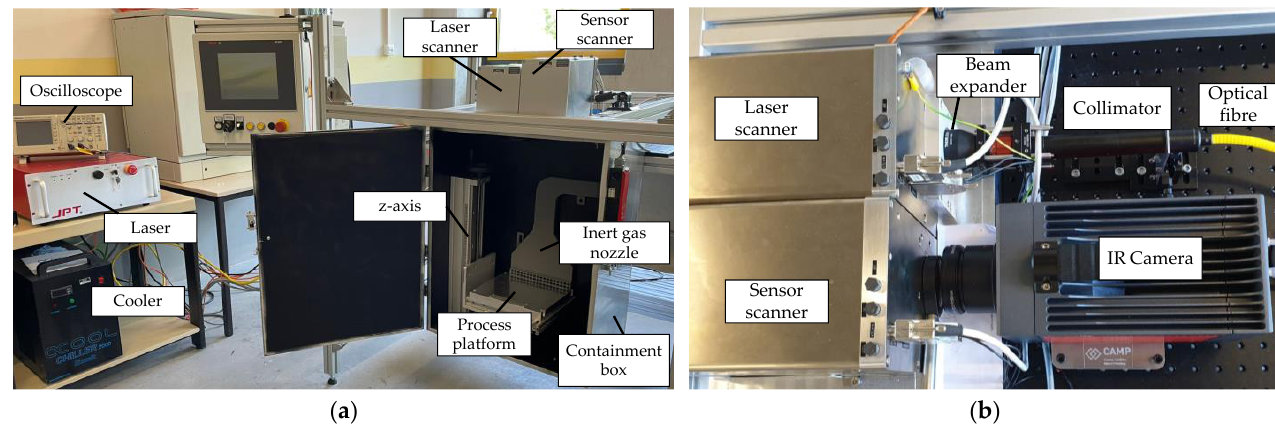
Figure 5. ( a , b ) Representation of the laboratory setup for the Synchronized Path Infrared Ther- mography system.